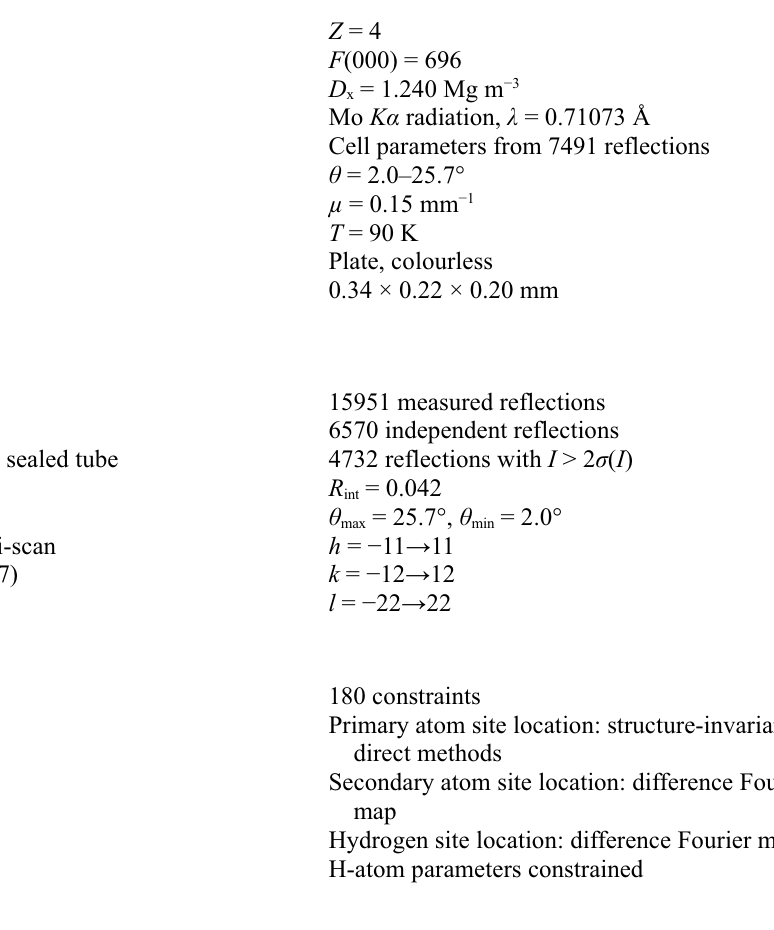
Figure 1 Structure showing 50% probability displacement ellipsoids for non-hydrogen atoms with hydrogen atoms as arbitary spheres (Burnett & Johnson, 1996). The two molecules differ mainly in the rotation about the C7 - O4 bond. N-[3-( tert -Butyldimethylsiloxymethyl)-5-nitrophenyl]acetamide Crystal